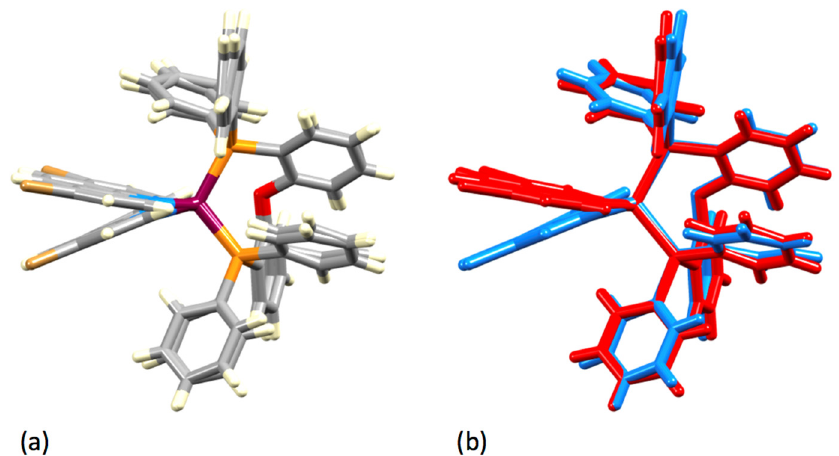
Figure 4. Overlay of the two independent cations in [Cu(POP)(4,7 ‐ Br 2 phen)][PF 6 ] ∙ CH 2 Cl 2 : ( a ) coloured by element colour, and ( b ) coloured to show the individual cations.